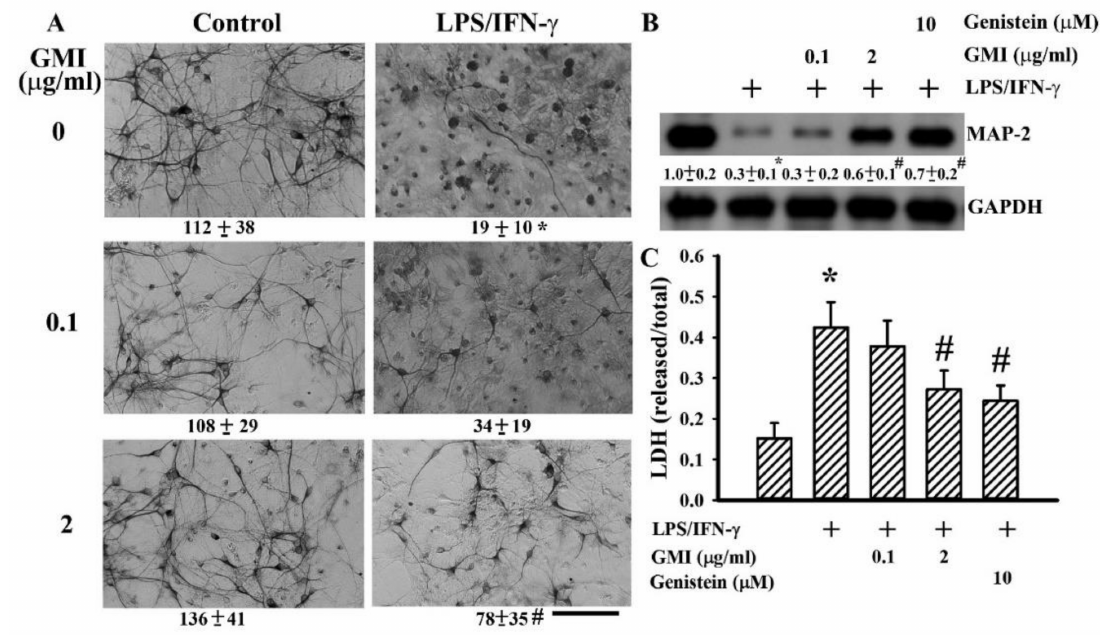
Figure 1. Ganoderma microsporum (GMI) alleviated neuronal cell death. ( A ) Neuron/glia cultures were pretreated with vehicle or various concentrations of GMI (0.1 and 2 µ g/mL) for 30 min before being incubated with LPS (100 ng/mL)/IFN- γ (10 U/mL) for an additional 48 h. Neuronal viability was detected by immunocytochemical staining of MAP-2. Representative micrographs and quantitative numbers are shown. Bar, 60 µ m. Neuron/glia cultures were pretreated with vehicle, various concentrations of GMI (0.1 and 2 µ g/mL), or genistein (10 µ M) for 30 min before being incubated with LPS (100 ng/mL)/IFN- γ (10 U/mL) for an additional 48 h. Total cellular proteins were extracted and subjected to Western blot analysis with indicated antibodies ( B ). One representative blot of four independent culture batches is shown and the fold of relative protein content is depicted under the blots. The protein content of untreated control was defined as 1.0. Cell damage was measured by LDH efflux assay ( C ). * p < 0.05 vs. untreated control and # p < 0.05 vs. LPS/IFN- γ control, n = 4. The + means the groups treated with LPS/IFN- γ and the rest groups without + indicate vehicle